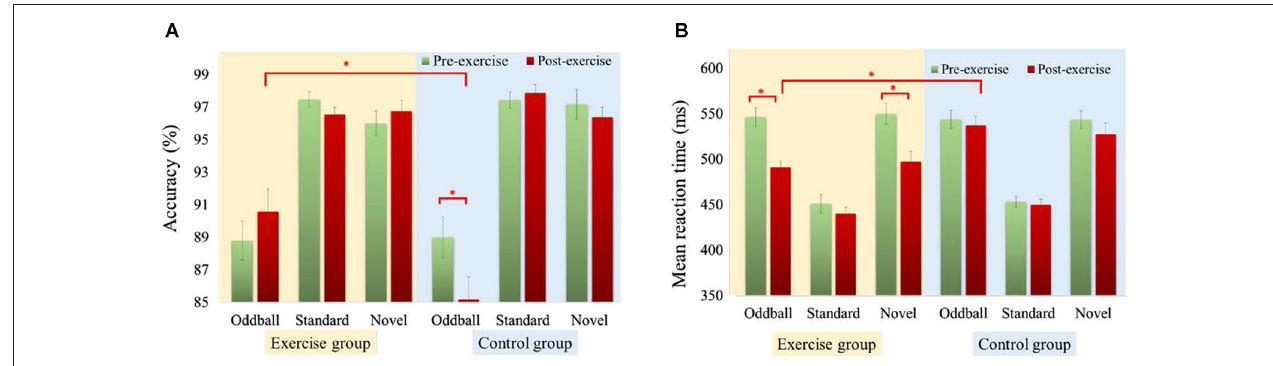
FIGURE 2 | Accuracy rate (A) and reaction time (B) performance of exercise and control groups during the oddball task at baseline and 12 months later in three conditions . *Significantly different ( p < 0.05). Statistical values expressed as mean ±